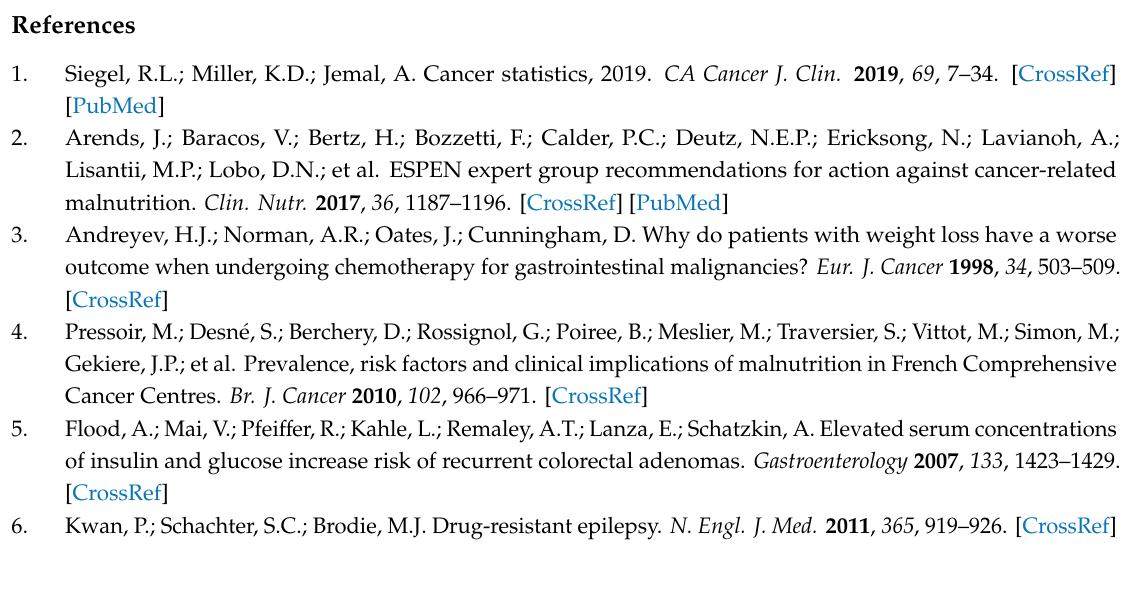
Figure S1: Examples of the ketogenic diet menu (carbohydrate 10 g / day), Figure S2: Additional blood parameters of patients on the ketogenic diet. Figure S3: Changes of body composition evaluated with the in body 720 on the ketogenic diet. Table S1: Nutritional contents of the ketogenic formula (per 100 g). Table S2: Background characteristics of patients ( n = 55), Table S3: Histological and therapeutic characteristics of patients ( n = 37), Table S4: Glucose, BHB, and GKI data of 37 patients after ketogenic diet. Table S5: Gastrointestinal symptoms rating scale (GSRS), Table S6: